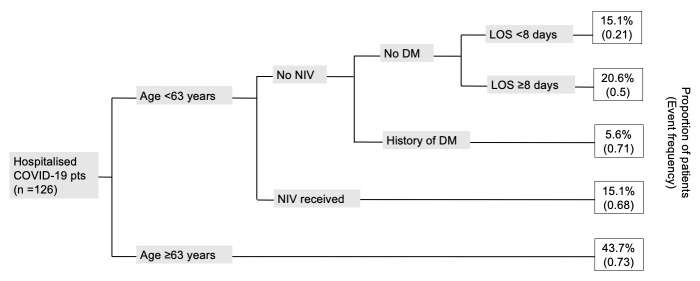
Regression tree analysis (RT 2) to predict the need of post-discharge follow-up among hospitalised patients recovered from COVID-19.Event frequency defines the proportion of patients needing follow-up. Age, gender, ethnicity, history of hypertension, coronary artery disease, chronic kidney disease, diabetes mellitus, administration of non-invasive ventilation, length of stay, and transfer to intensive care unit were included in RT 2 analysis. Pts, patients. NIV, non-invasive ventilation. LoS, length of stay.